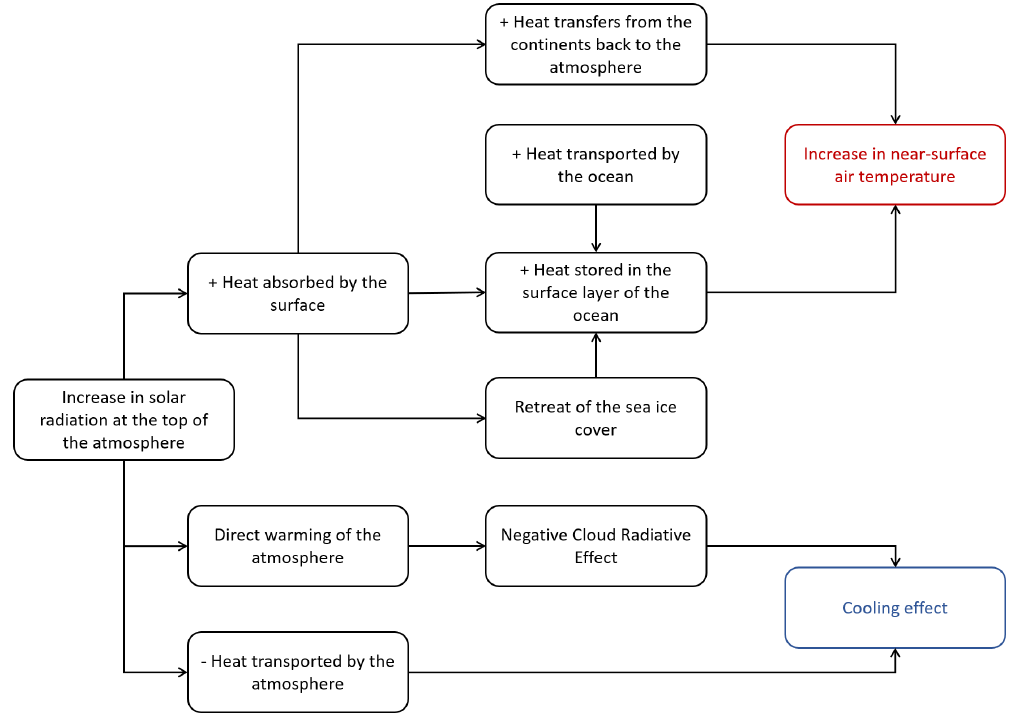
Figure 13. Diagram of the Last Interglacial climate processes and feedback involved in the Arctic summer